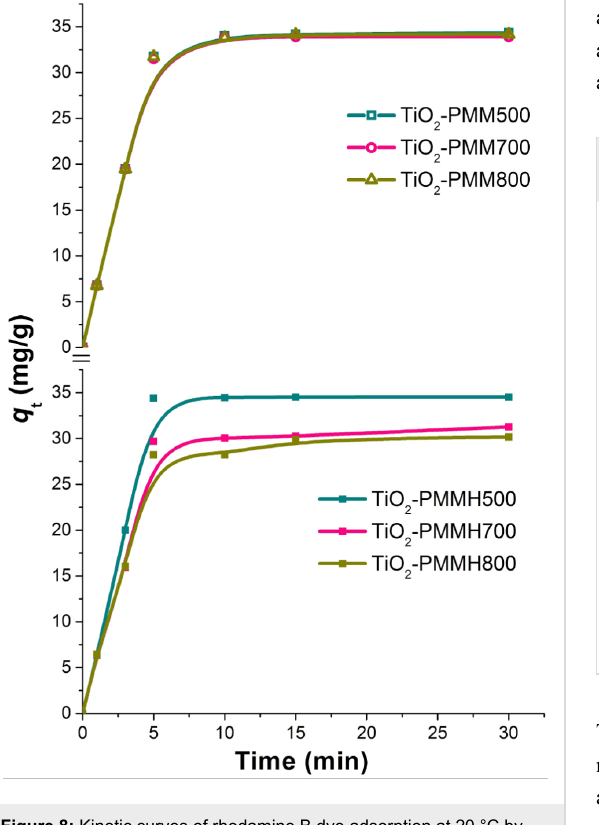
Figure 8: Kinetic curves of rhodamine B dye adsorption at 20 °C by the TiO 2 -PMM x , and TiO 2 -PMM Н x samples.